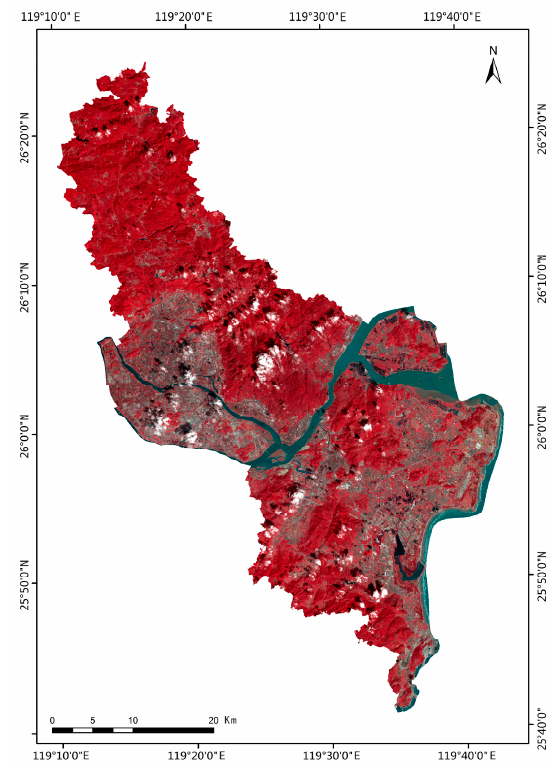
Figure 3. Remote sensing images of Fuzhou city in 2022.